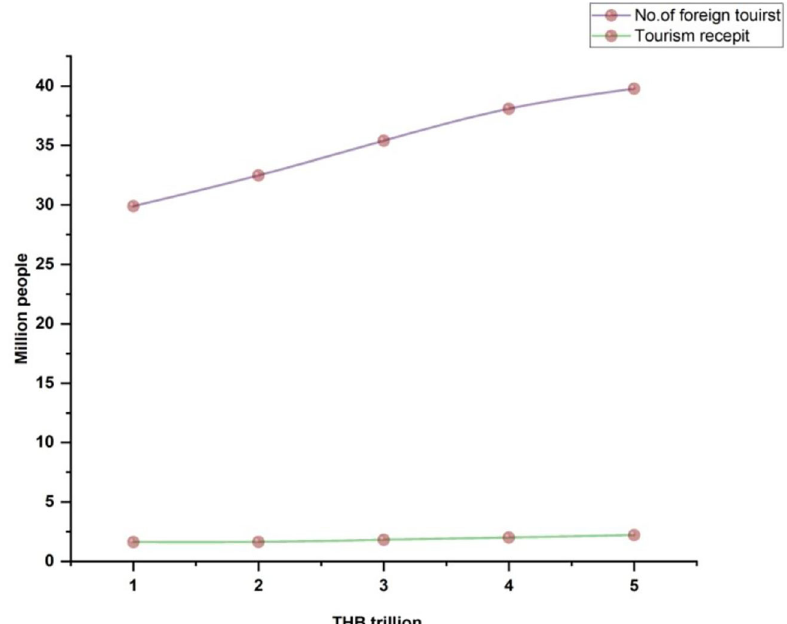
Figure 1. Thailand international tourist arrival.